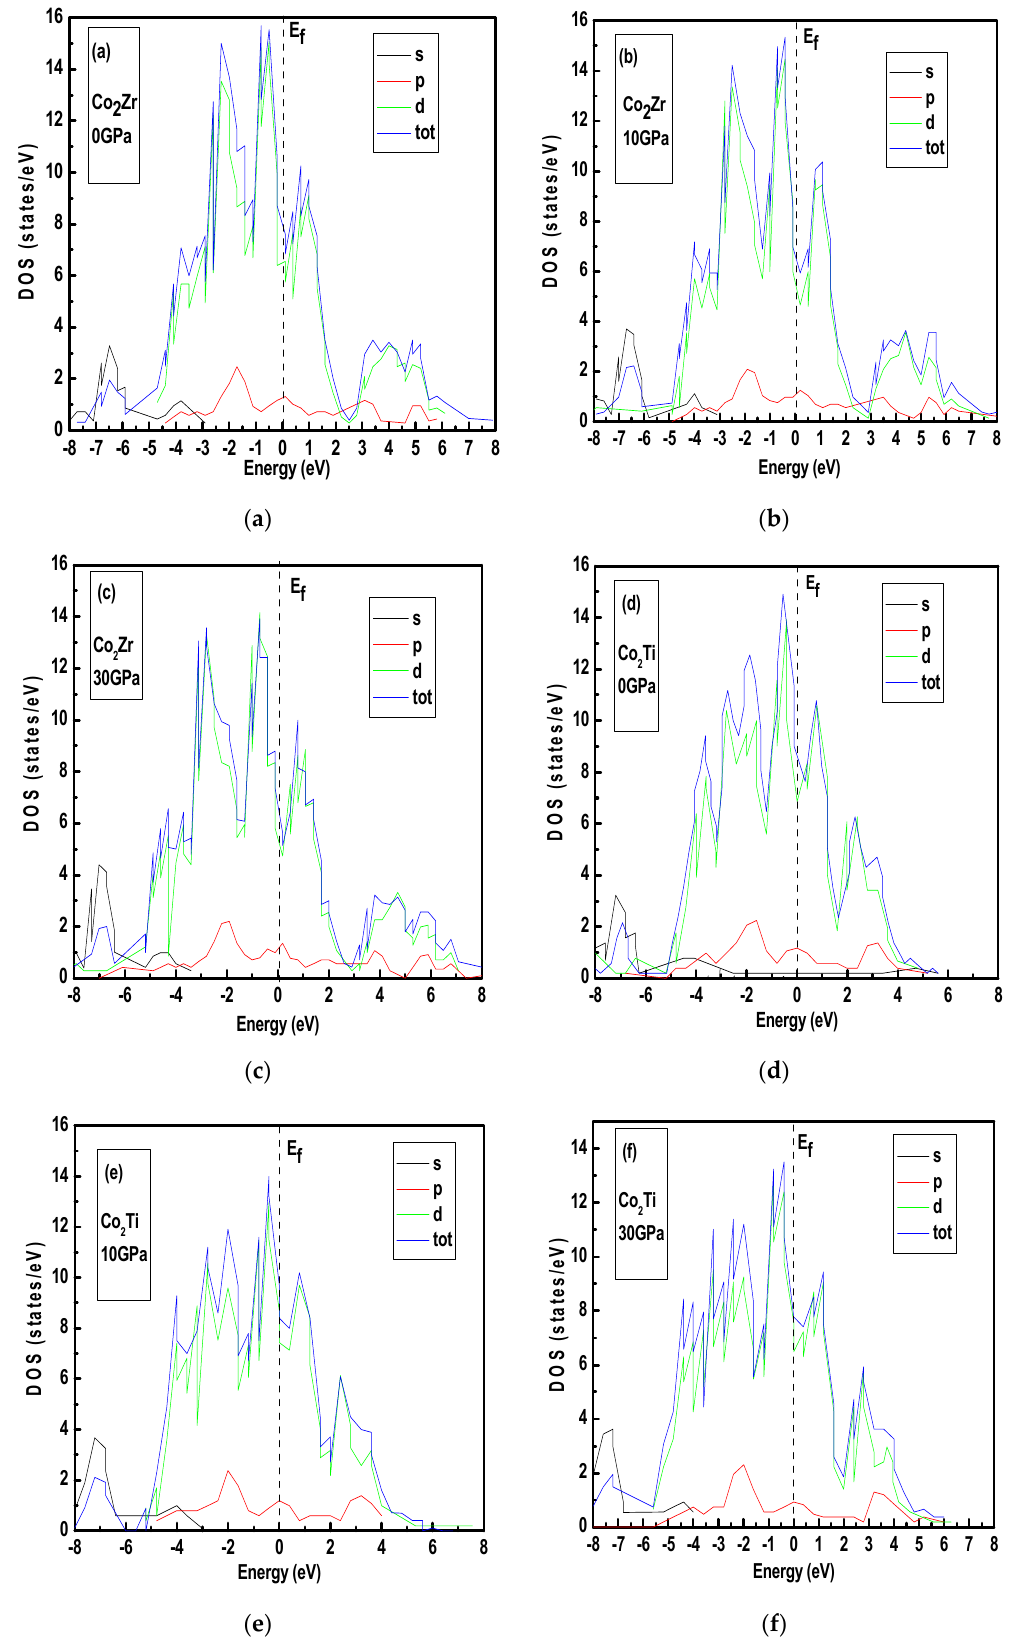
Figure 7. The total density of states and partial density of states of Co 2 Zr at ( a ) 0, ( b ) 10, and ( c ) 30 GPa; and that of Co 2 Ti at( d ), ( e ) 10, and ( f ) 30 GPa.